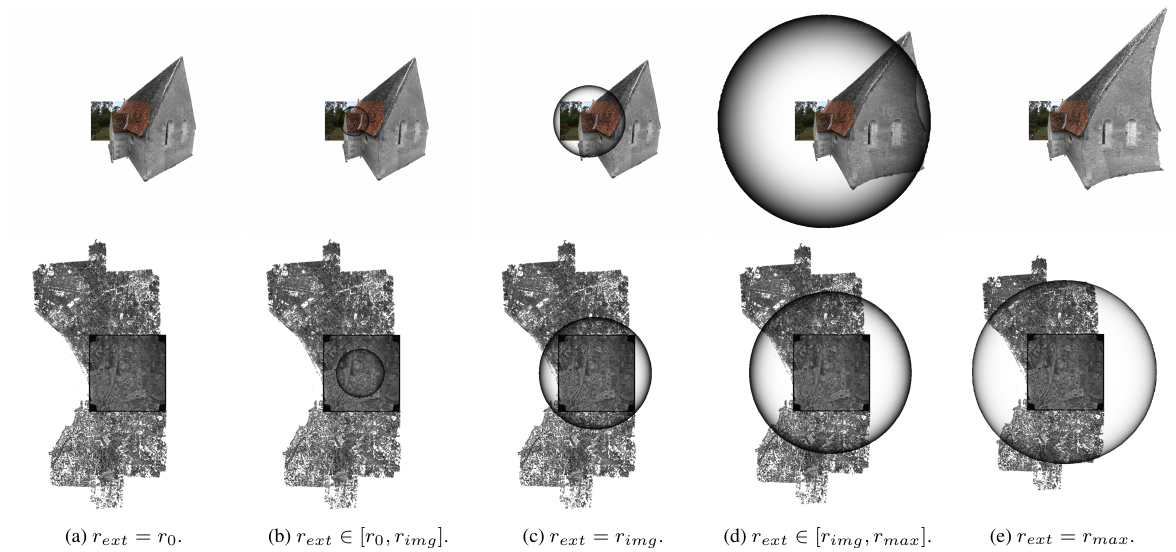
Figure 8. Outcomes in the employed datasets when the extrapolation radius r ext variates in the range of [0 , r max ] (the circle with the black shading has radius r ext and is only for illustrative